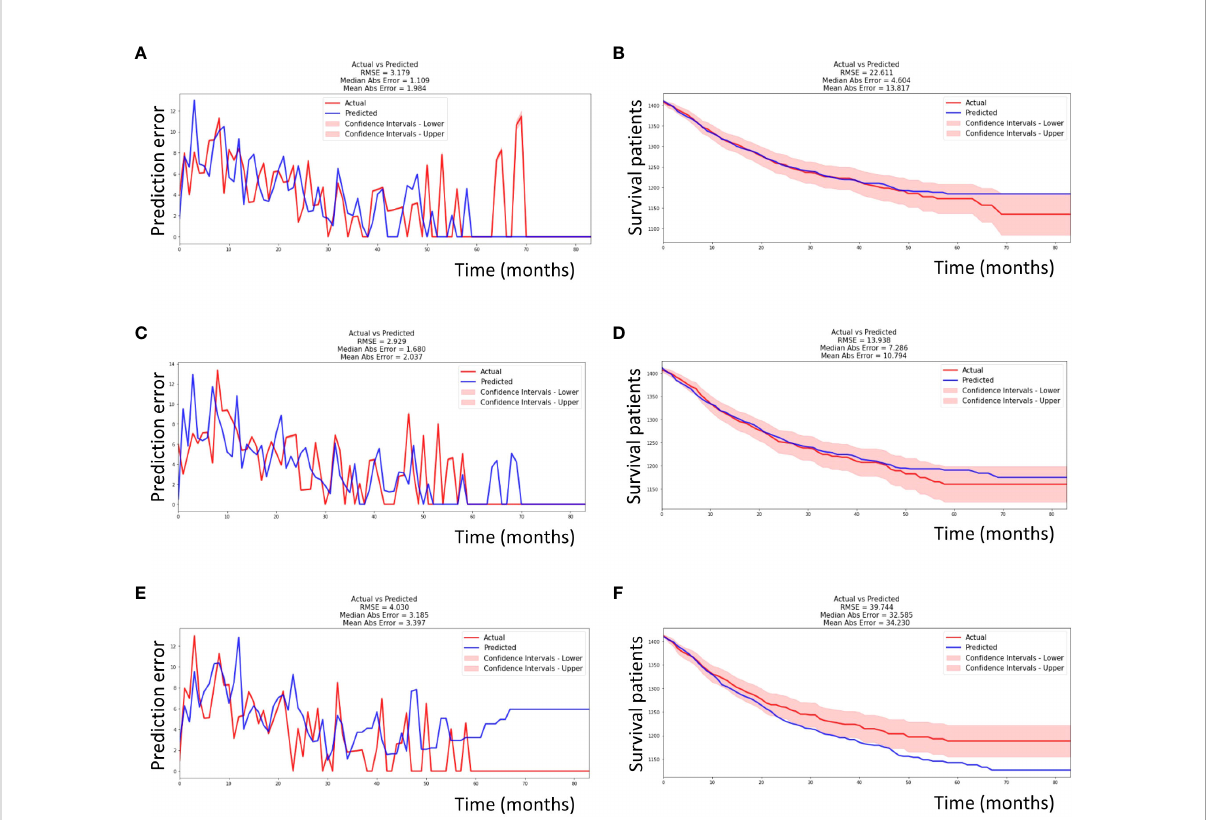
FIGURE 3 Performance of each machine learning model. (A) The EST model had an RMSE of 3.719 and MAE of 1.984 during seven-years of follow-up time in testing set. (B) The EST model had an RMSE of 22.611 and MAE of 13.817 in survival curve prediction. (C) Similarly, the CSF model had an RMSE of 2.929 and MAE of 2.037. (D) The CSF model had an RMSE of 13.938 and MAE of 10.794 in survival curve prediction. (E) Similarly, the DeepSurv model had an RMSE of 4.030 and MAE of 3.397. (F) The DeepSurv model had an RMSE of 39.744 and MAE of 34.230 in survival curve